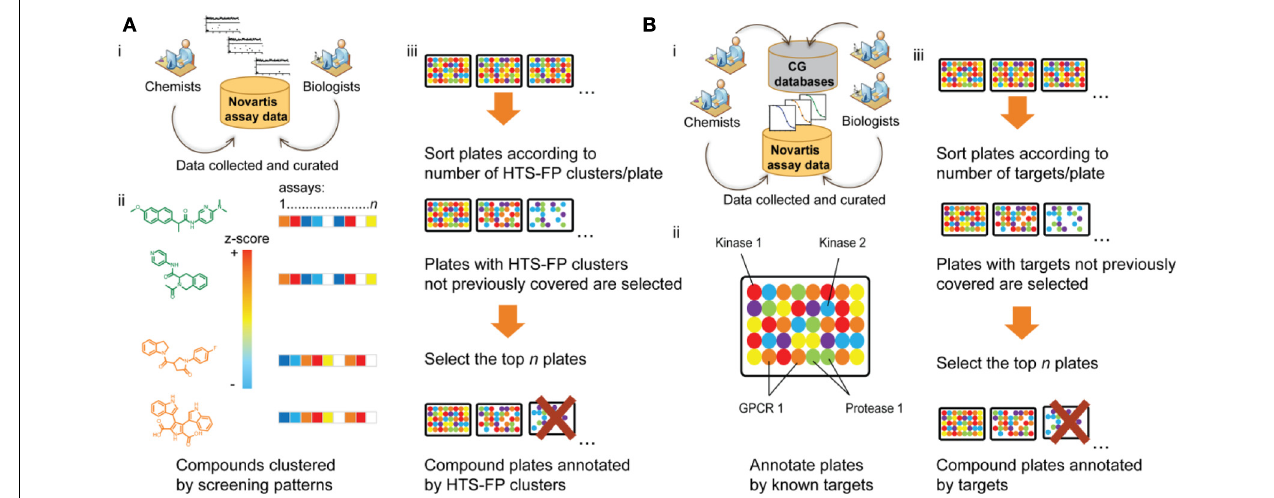
FIGURE 2 | Shown are two different approaches developed at Novartis for the design of biodiverse compound libraries from a pre-plated screening deck. (A) For each compound in the Novartis screening collection, primary assay data from more than 200 HTS campaigns are collected, standardized in form of z -scores, and stored in a minable activity pattern (HTS-FP). This requires construction of a robust bioassay ontology and curation of compound and assay information. Then compounds are clustered by their activity patterns and screening plates are ranked in descending order of the number of different bioactivity clusters covered by the compounds contained in each plate. The more clusters are found on a plate, the more